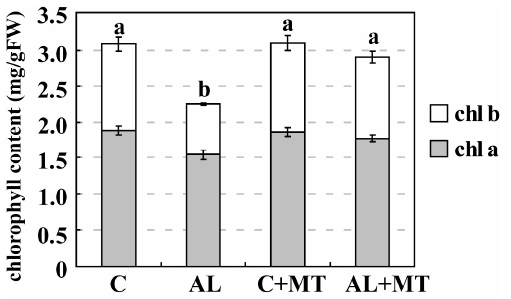
Figure 2. Chlorophyll (chl) concentrations in Malus hupehensis Rehd. seedlings in response to alkaline stress and/or melatonin treatment. Lower-case letters indicate significant differences among treatments, based on Duncan’s multiple range test ( p < 0.05).